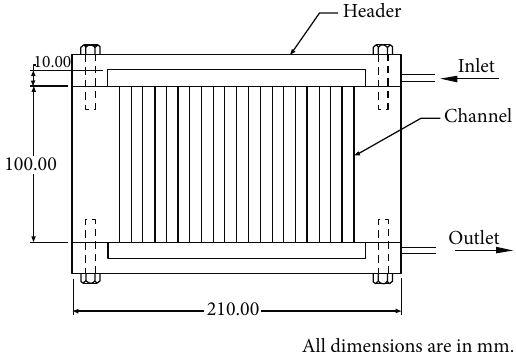
Figure 3: SEM image of Al